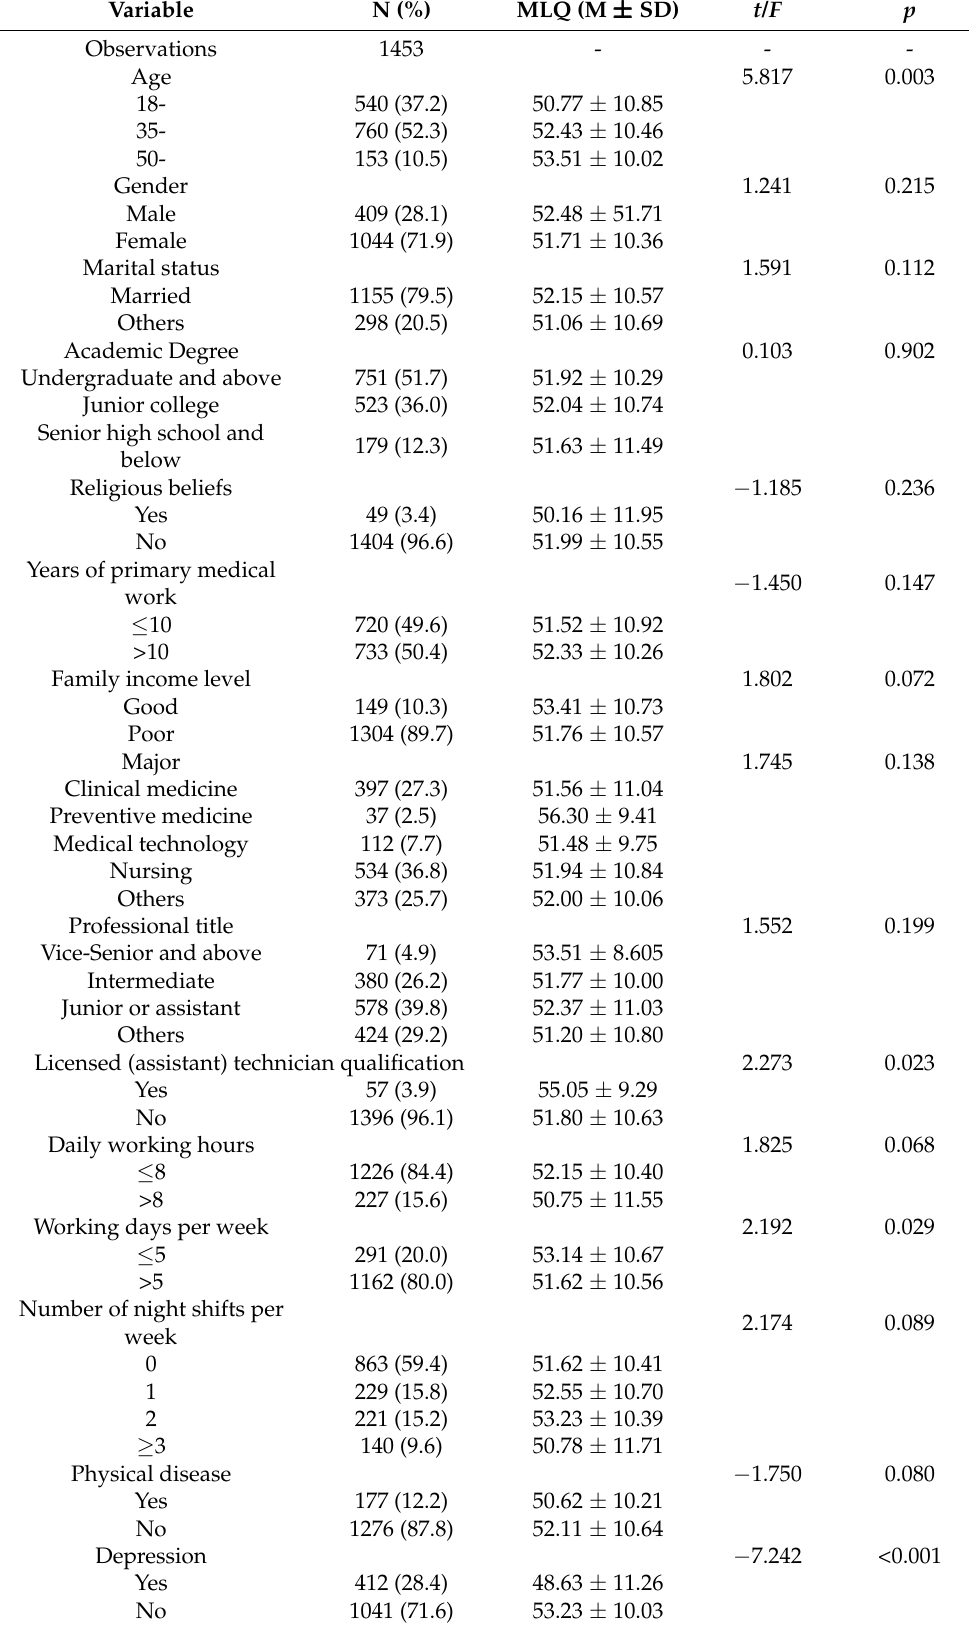
Table 1. Sample characteristics and single analysis of MLQ among the GPs in Shandong,